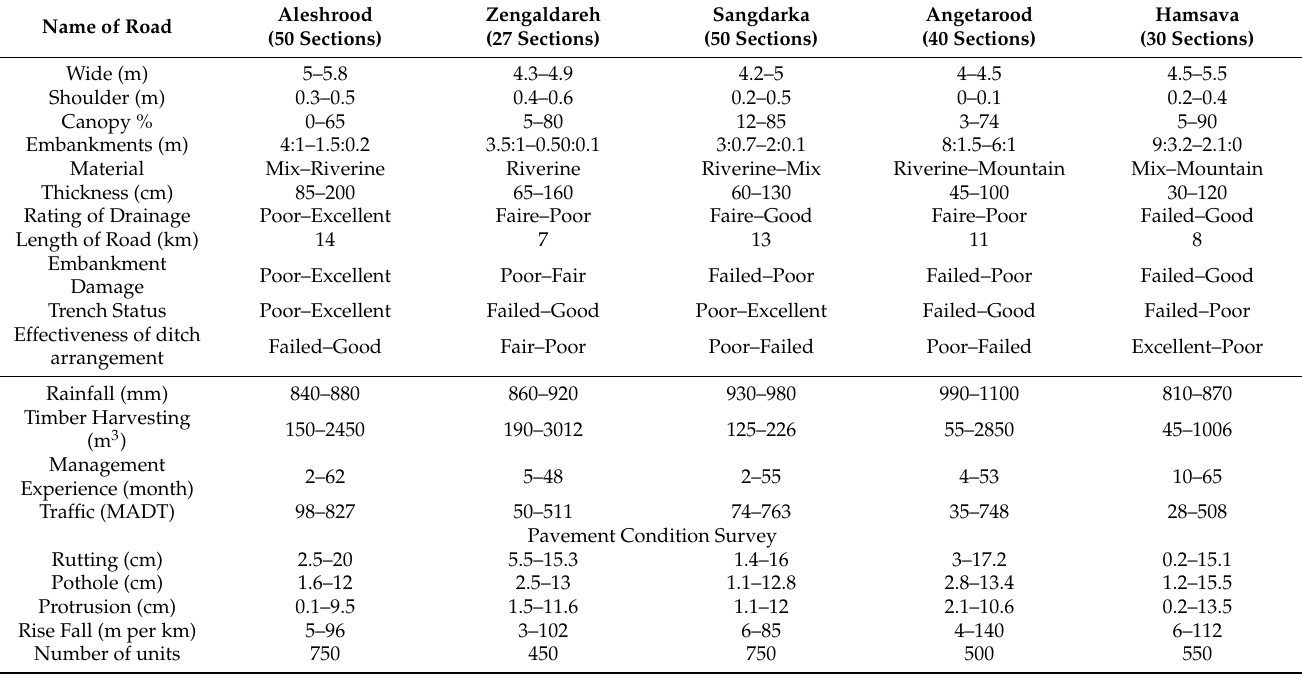
Table 3. General information and Pavement Survey Data in section division of study area.